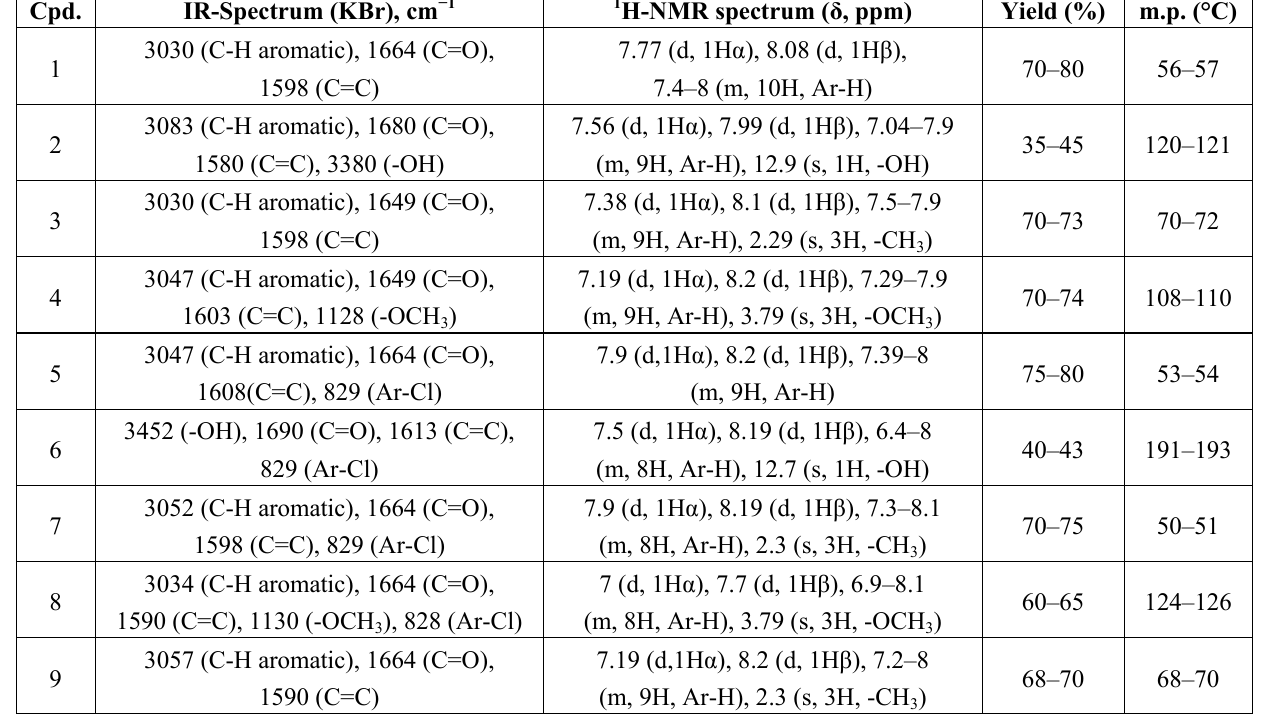
Table 2. Spectral data, yield and melting point of compounds